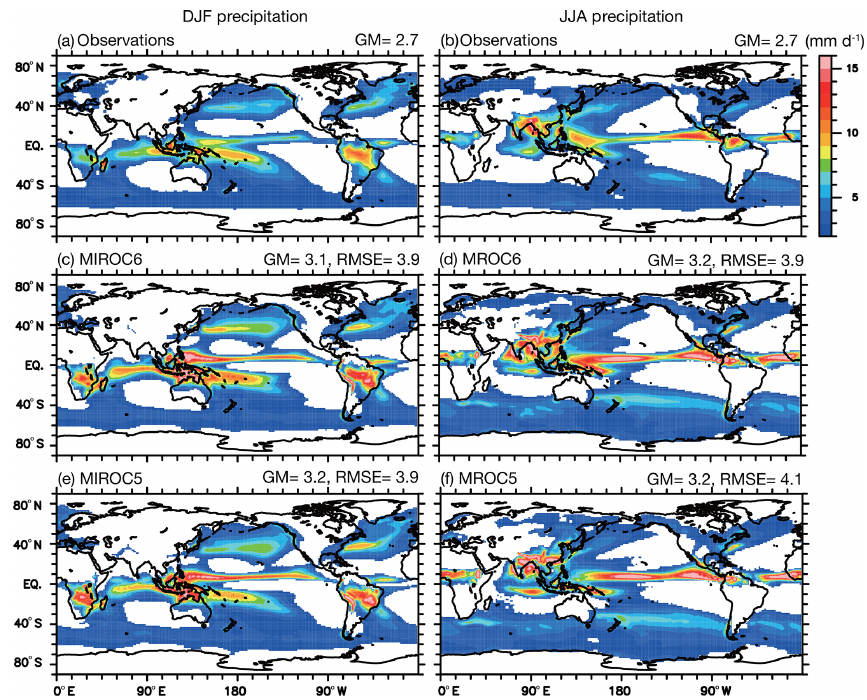
Figure 8. Precipitation in boreal winter (December–February; a, c, e ) and summer (June–August; b, d, f ) in observations ( a, b ; GPCP), MIROC6 (c, d) , and MIROC5 (e, f) . Areas with precipitation less than 3mmd − 1 are not